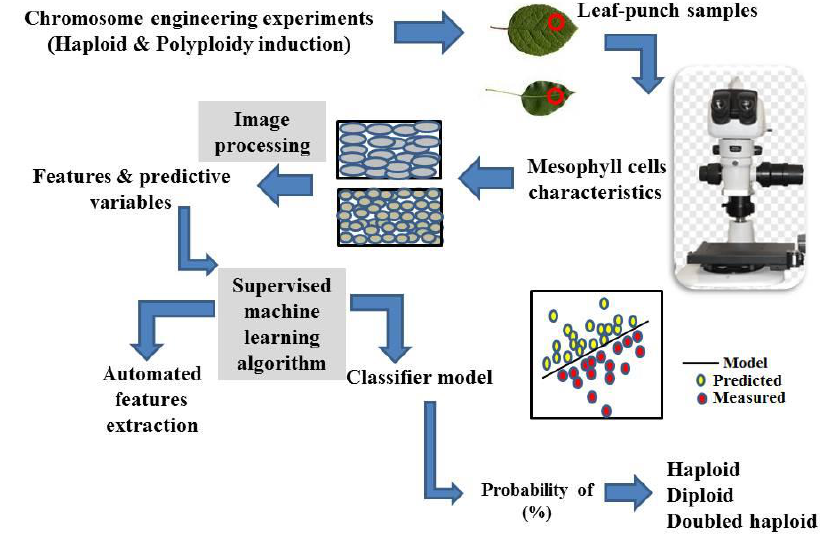
Figure 3. The proposed coupled image processing-supervised machine learning to determine the ploidy level in different plant species through cellular patterning in leaf epidermis and mesophyll